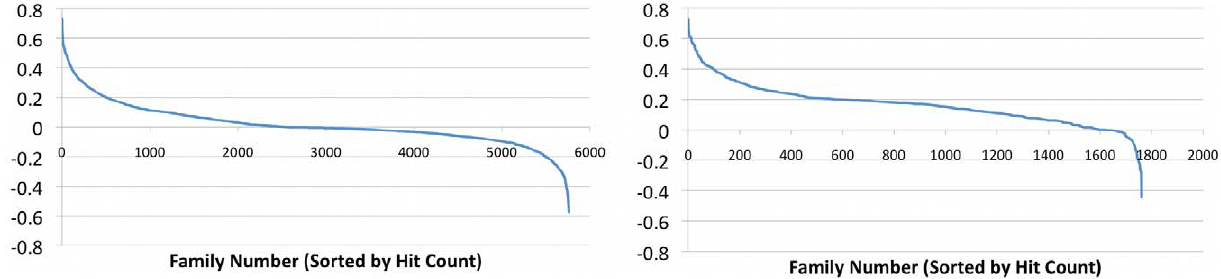
Figure 3. The distribution of ‘‘essentiality coefficients’’ for protein families. PFAM families [5] are shown on the left and the new families introduced in this manuscript on the right panel.